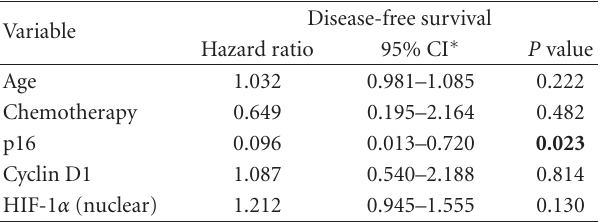
Table 4: Multivariate Cox regression analysis.